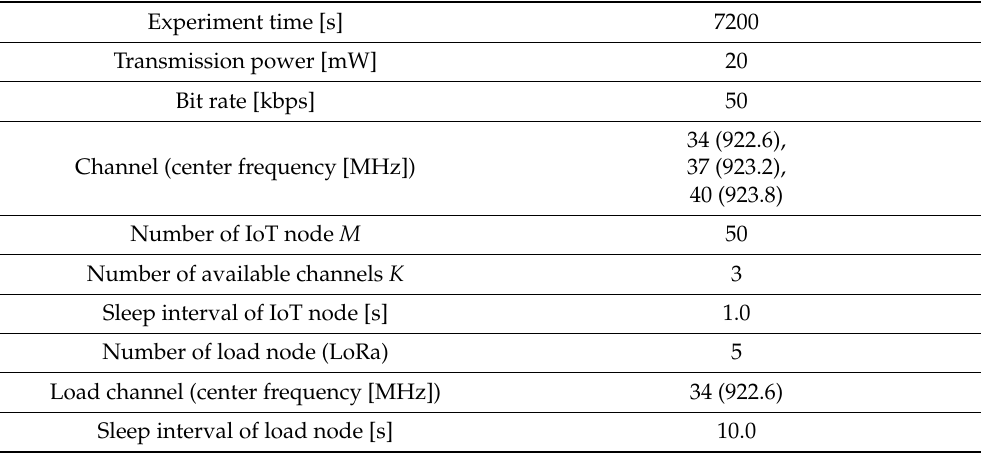
Table 3. The experimental settings.